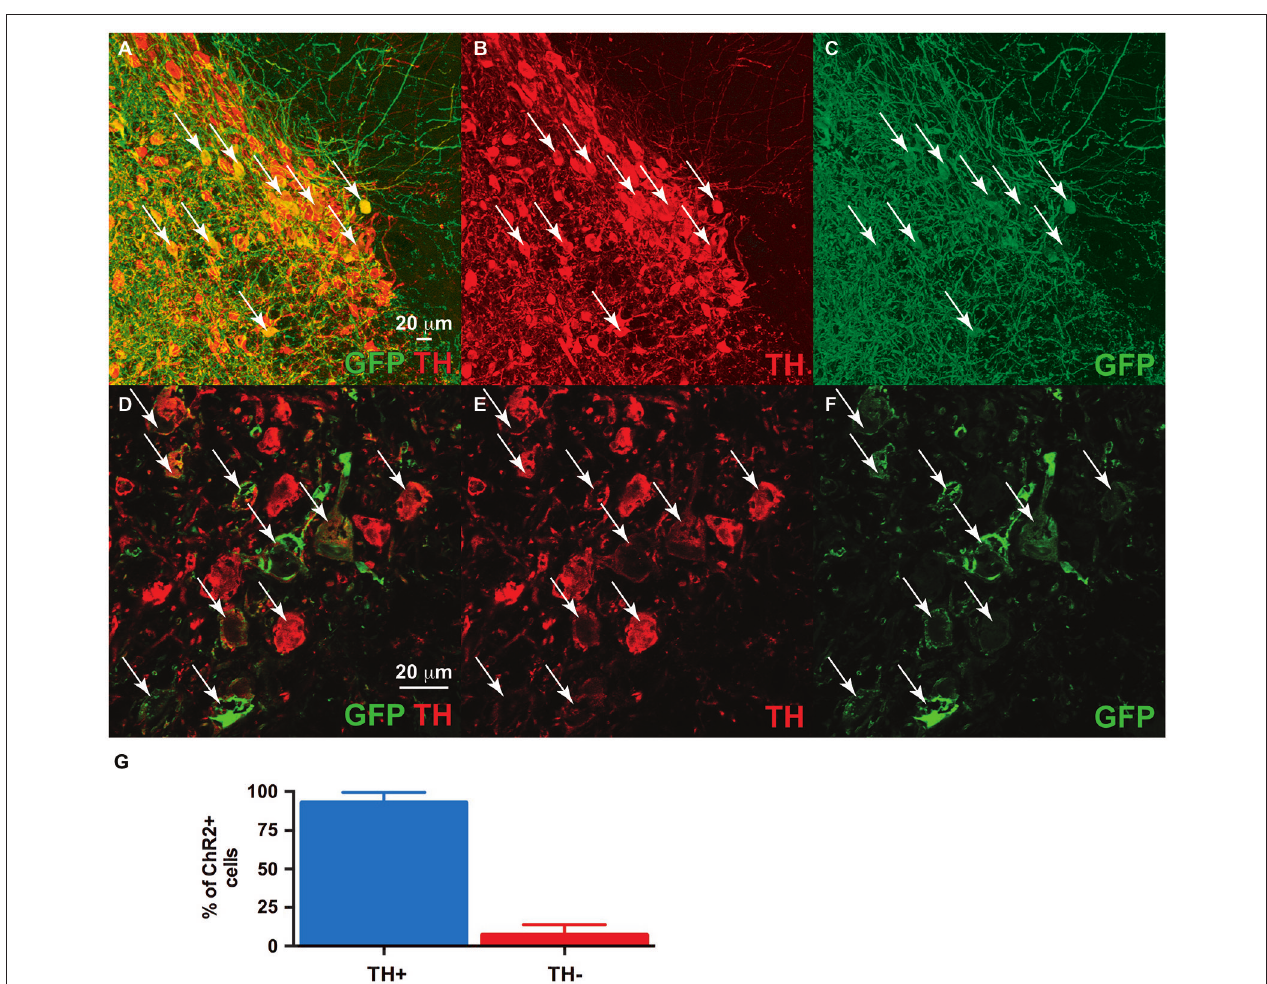
ChR2+ neurons also demonstrating TH (arrows), while some TH+ neurons are either not expressing ChR2 or doing so at levels below detection limit of this experiment. (G) Quantification of TH/ChR2 colocalization. ChR2+ neurons were identified as either TH+ or TH- ( n = 4, total of 427